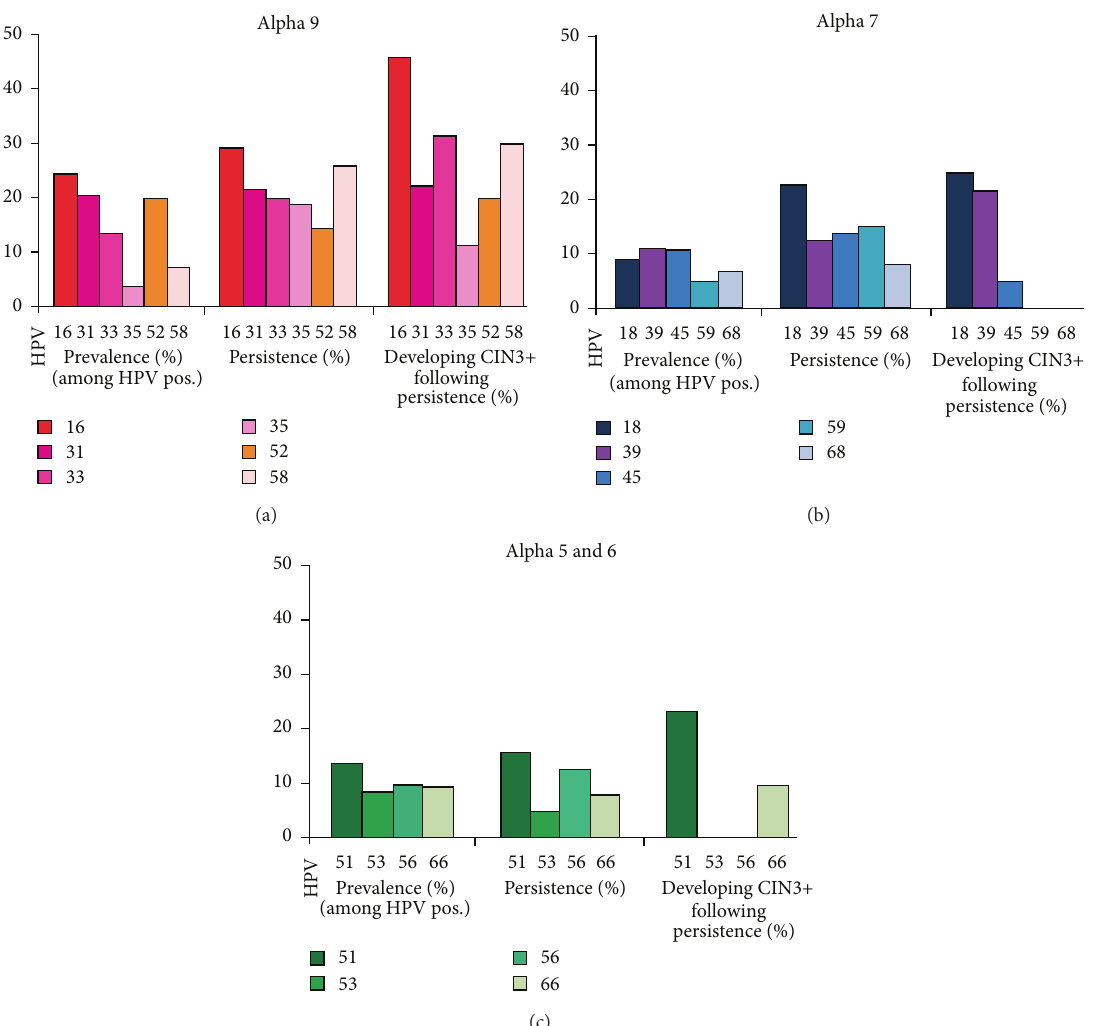
Figure 2: High-risk human papilloma virus type-specific prevalence of infection, percentage of women with a persistent infection and percentage of women with persistent infection who developed CIN3 or worse during follow-up period of more than 13 years after one positive test for high-risk HPV or a persistent infection (defined as two positive tests) with various specific high-risk HPV types in women with normal cytological findings